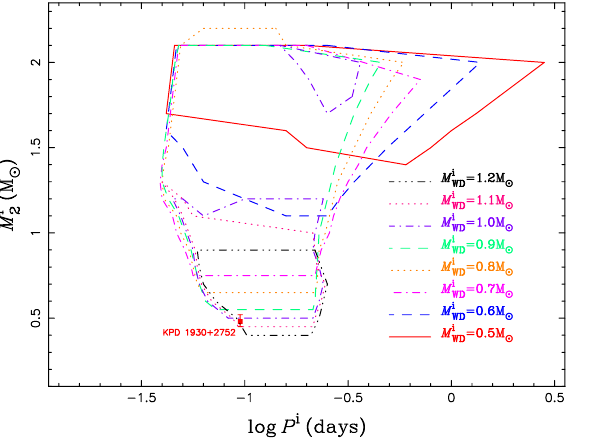
Figure 2. Delay time distributions of SNe Ia based on the DD model. The solid, dashed and dash-dotted lines present the cases with α CE λ = 0.5, 1.0 and 1.5, respectively. The thick curves represent the delay time distributions of SNe Ia from the WD+He subgiant chan- nel, and the thin ones show that from all channels. Points with error bars represent the observational date of elliptical galaxies from the Subaru/XMM−Newton Deep Survey (the open circles; Totani et al. 2008), galaxy clusters at the redshifts from Z = 0 to Z = 1.45 (the filled triangles; Maoz et al. 2010), a galaxy sample from SDSS (the filled squares; Maoz et al. 2012), and an SN Ia sample from the Cluster Lensing And Supernova survey with Hubble (the open square; Graur & Maoz